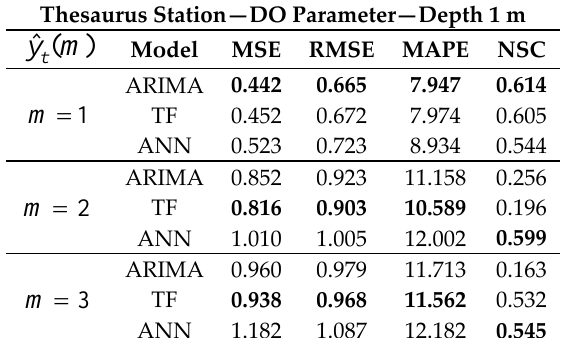
Table 1. Statistical parameters for comparison observed and predicted values using ARIMA, TF and ANN models and m = 1, 2 and 3 (depth 1 m).